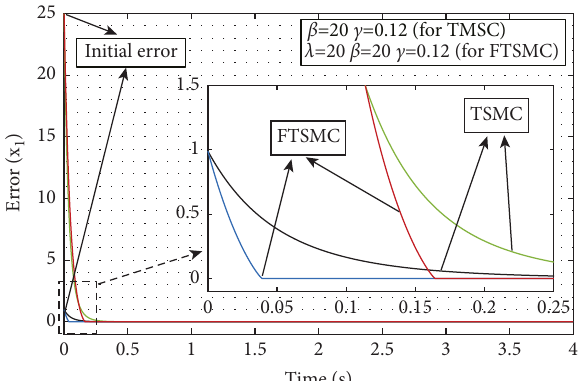
Figure 5: Comparison of error trajectory of FTSMC and TSMC for far away and near initial